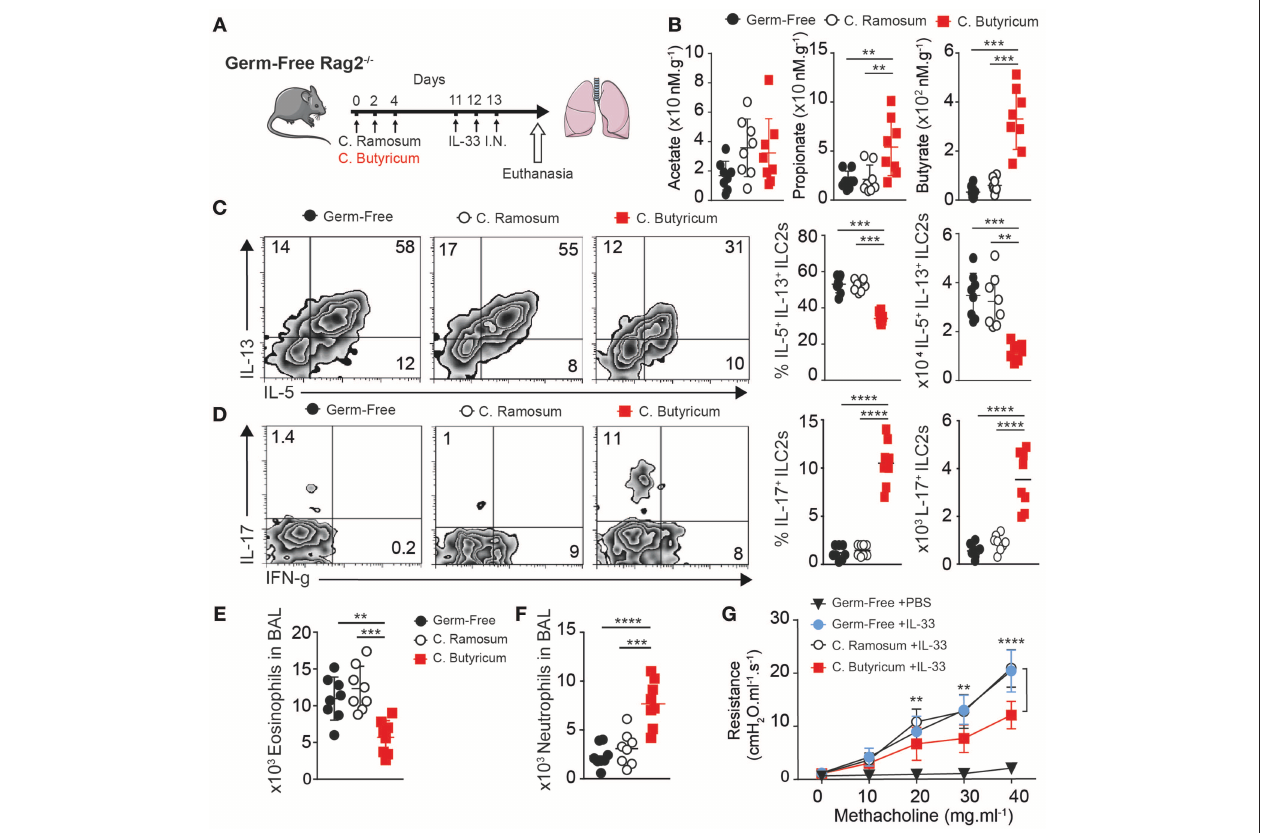
FIGURE 5 | Clostridia butyricum provides systemic butyrate to dampen ILC2 dependent AHR. Germ-free RAG − / − mice gavaged with 1 × 10 6 pfu Clostridia butyricum and Clostridia Sporogenes (butyrate producer, BUT + ) or two strains of Clostridia ramosum (non-butyrate producer, BUT–) every other day over 5 days, followed by once daily 0.5 ug rmIL-33 challenge intranasal for 3 days. Twenty four hours after last challenge, Lung function and composition was analyzed. (A) Schematic. (B) SCFA levels in Lung homogenate measured by LC-MS. (C) Representative flow plots, percentage and number of IL-5 and IL-13 producing ILC2 in BAL after PMA ionomycin/BFA. (D) Representative flow plots, percentage and number of IL-17a producing ILC2 as in (C) . (E) Total Eosinophils in BAL. (F) Total Neutrophil count in BAL. (G) Lung resistance (AHR) upon methacholine challenge. Data representative of two independent experiment, n = 8 mice/group + -SEM. * p < 0.05, ** p < 0.01, *** p < 0.001, and **** p <